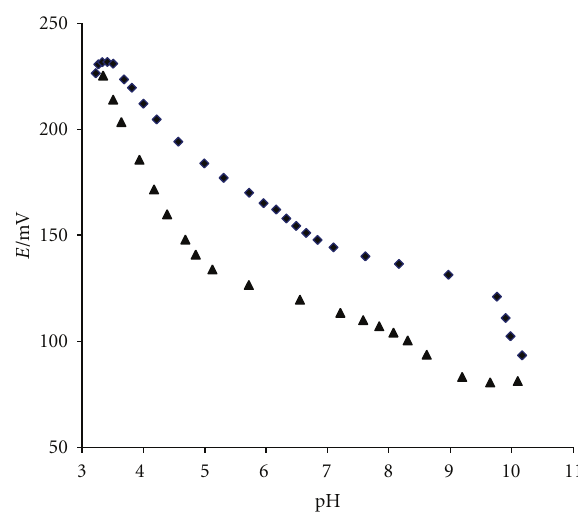
Figure 3: Electrode potential of nonporous polycrystalline hematite electrode (equilibration time: ∼ 10 min) as a function of pH of the solution in the presence of NaClO 4 ( c = 10 − 3 mol dm − 3 ). Titration of acidic solution with NaOH ( (cid:2) ), and back titration of basic solution with HClO 4 ( (cid:3) ). Temperature: 25.0 ◦